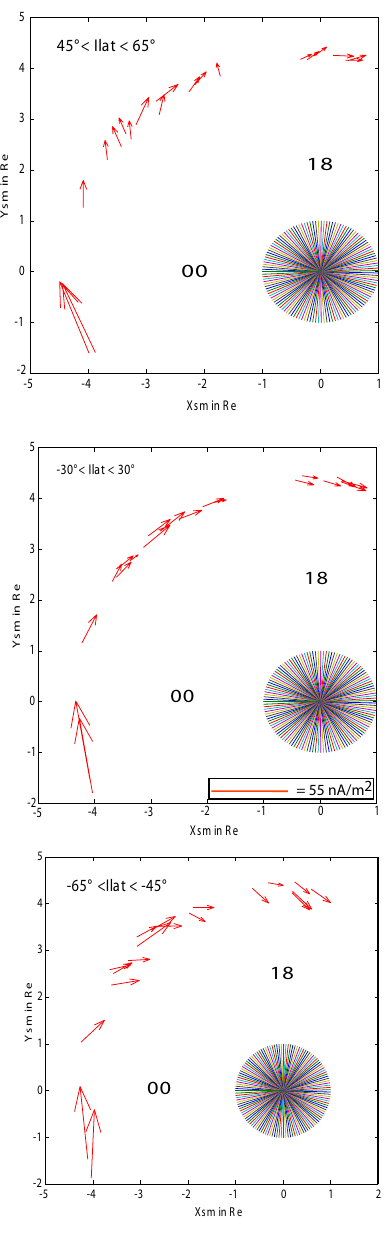
Fig. 15. Current density vectors for the February-June 2002 Cluster perigee passes, averaged over three invariant latitude intervals, and projected down to the equatorial plane: ( a ) from 45 ◦ to 65 ◦ ( b ) from − 30 ◦ to 30 ◦ ( c ) from − 45 ◦ to − 65 ◦